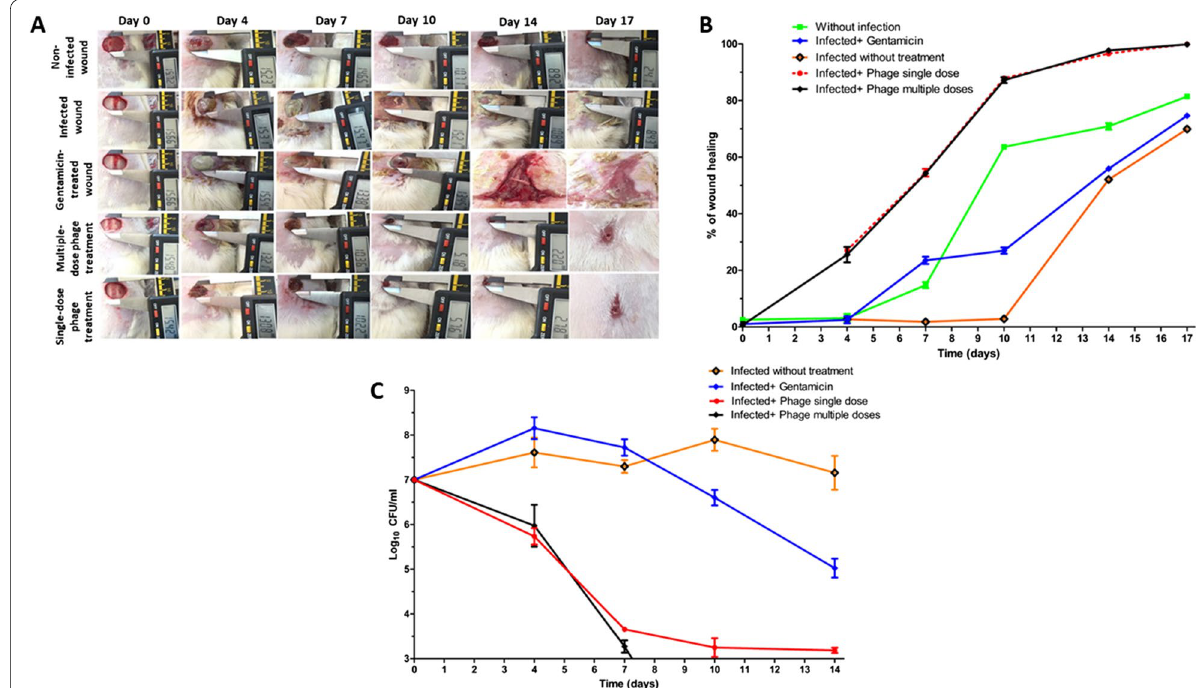
Fig. 6 The nontreated and noninfected wound (positive control; group 1), nontreated infected wound (negative control; group 2), infected wound treated with gentamicin antibiotic (group 3), infected wound treated with multiple phage doses (group 4), and the infected wound treated with